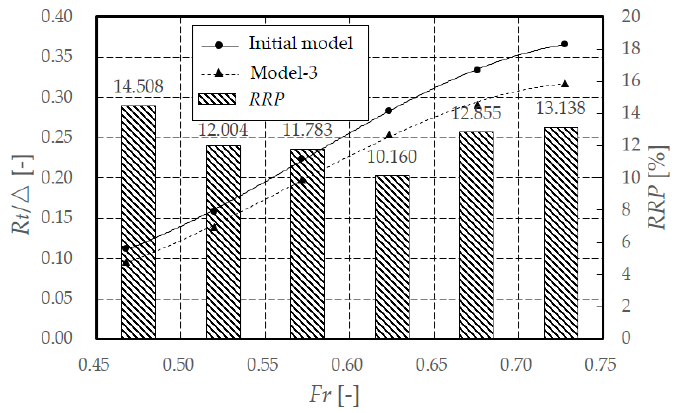
Figure 24. The resistance reduction effect of the ultimate resistance improvement model.